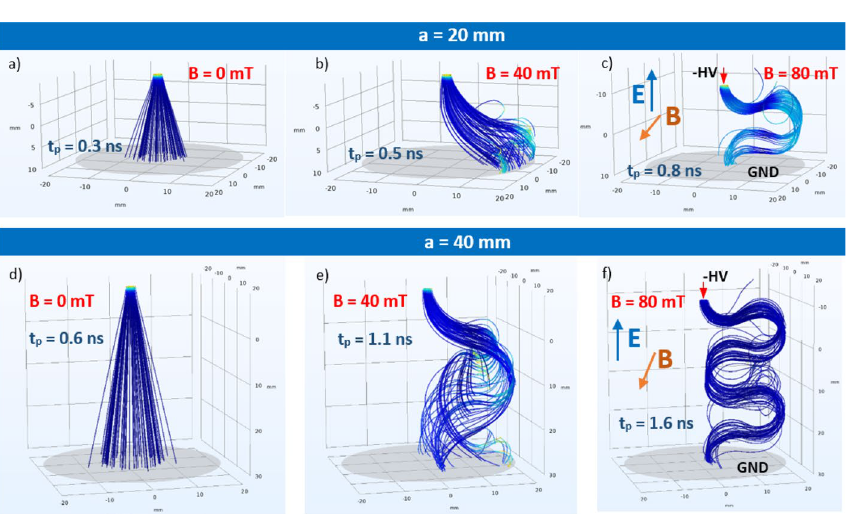
Figure 3. Comparison of electron trajectories in crossed electric and magnetic fields for interelectrode gap distance a = 20 mm (upper row) and a = 40 mm (lower row) at HV voltage U = − 10 kV for magnetic field induction: ( a ) B = 0 mT; ( b ) B = 40 mT; ( c ) B = 80 mT; ( d ) B = 0 mT; ( e ) B = 40 mT; ( f ) B = 80 mT. Orientation of E , B fields and electrode description in Graphs ( c ) and ( f